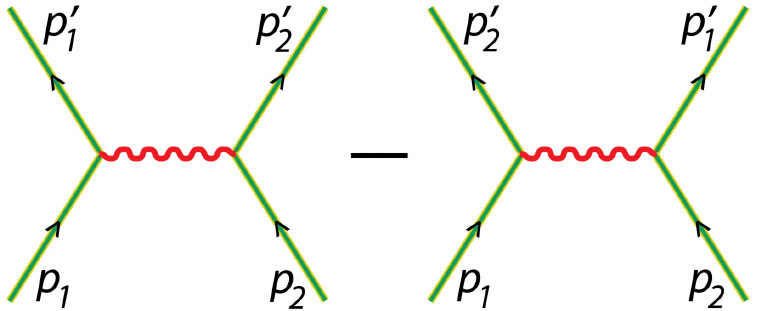
Figure 2. Feynman diagrams representing the scattering of electrons with initial ( p 1 and p 2 ) and final ( p (cid:48) and p (cid:48) ) four-momenta. All particles are on their mass 2